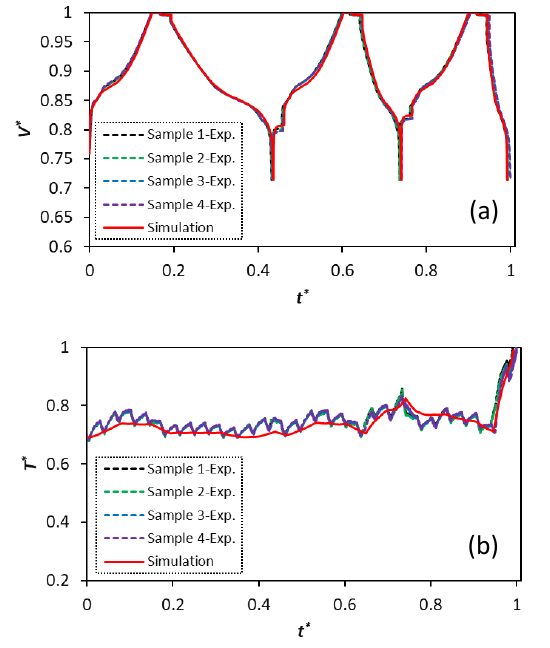
Figure 8. Cycling calibration optimization results for the aggregate cell. ( a ): voltage profiles; ( b ): temperature